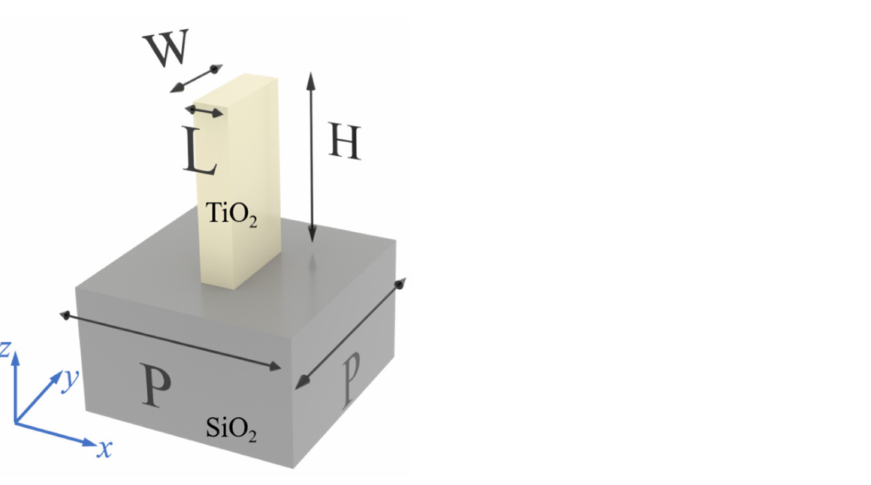
Figure 1. A unit cell with a TiO 2 nanostructure standing on an SiO 2 substrate.